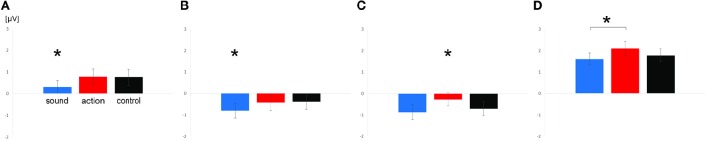
Means and standard errors of analyzed scalp regions in Experiment 1. Depicted are mean ERPs of sound, action, and control verbs over central scalp regions for the time window 180–280 ms (A) and 280–380 ms (B) and over parietal scalp regions for the time window 180–280 ms (C) and 280–380 ms (D). Significant effects are highlighted by asterisks.